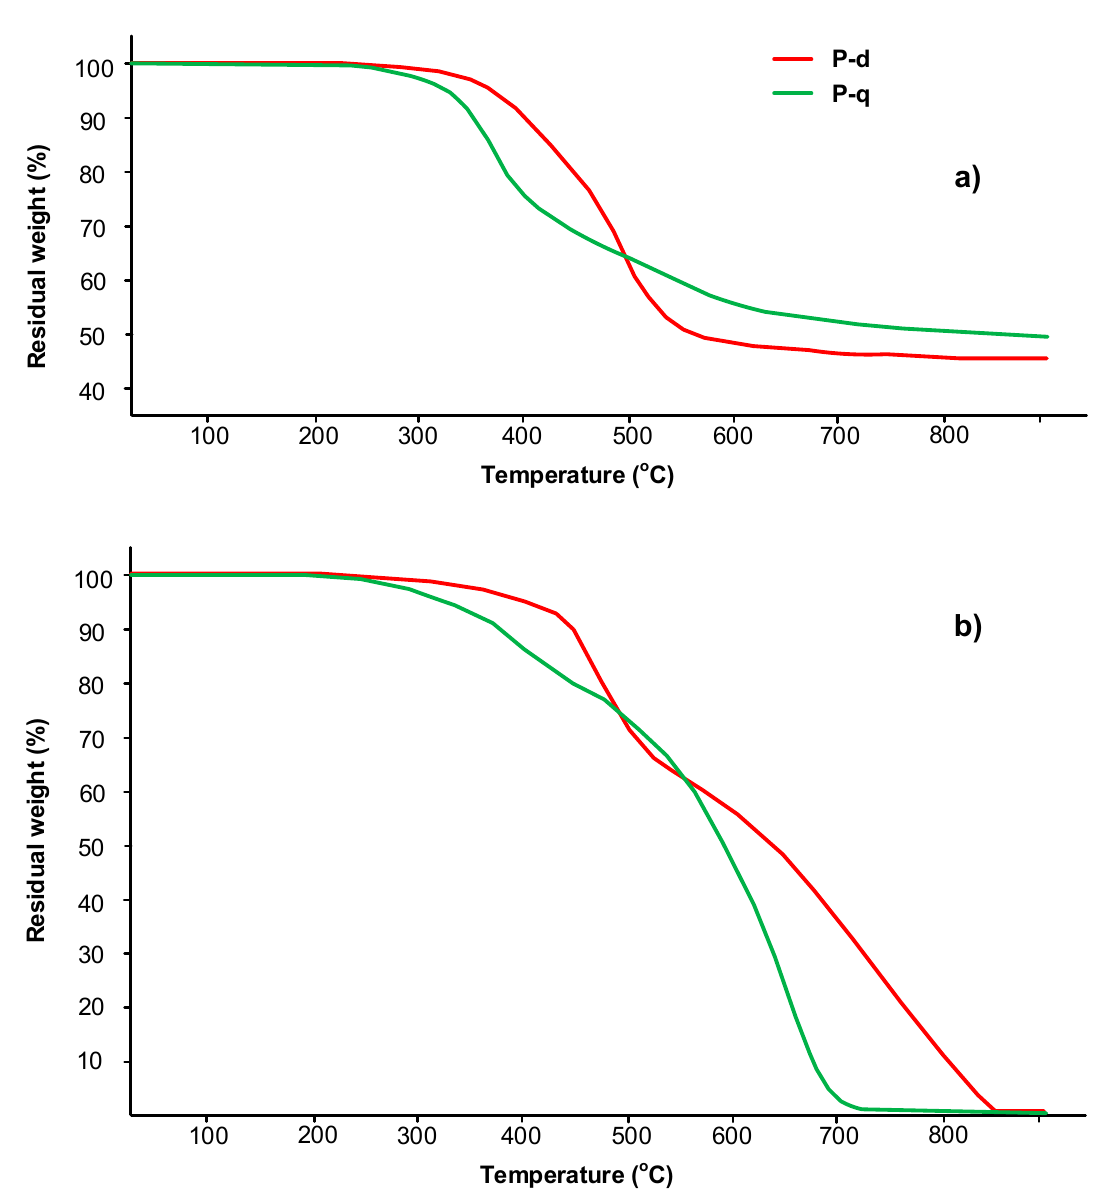
Figure 7. TGA curves of benzoxazine monomers P-d and P-q: ( a ) in the argon; ( b ) in the air atmosphere. Figures 8 and 9 show that the temperature of 5% mass loss for monomers P-d and P- q in air 407 °C and 333 °C, respectively, and in argon, 366 °C and 327 °C, respectively. These temperatures indicate the stability of the materials under the selected curing mode. The char yield at 800 °C for P-d and P-q in argon was 45 and 50%, respectively; in air, both monomers burned out without residue at 800 °C.